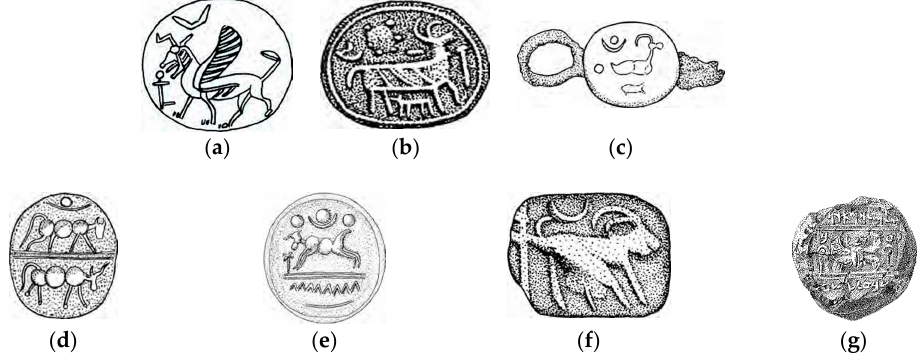
Figure 6. Seals with an animal and crescent moon: ( a ) ʿ Amman 4; ( b ) Tall al- ʿ Umeiri 66; ( c ) Hisban 2;